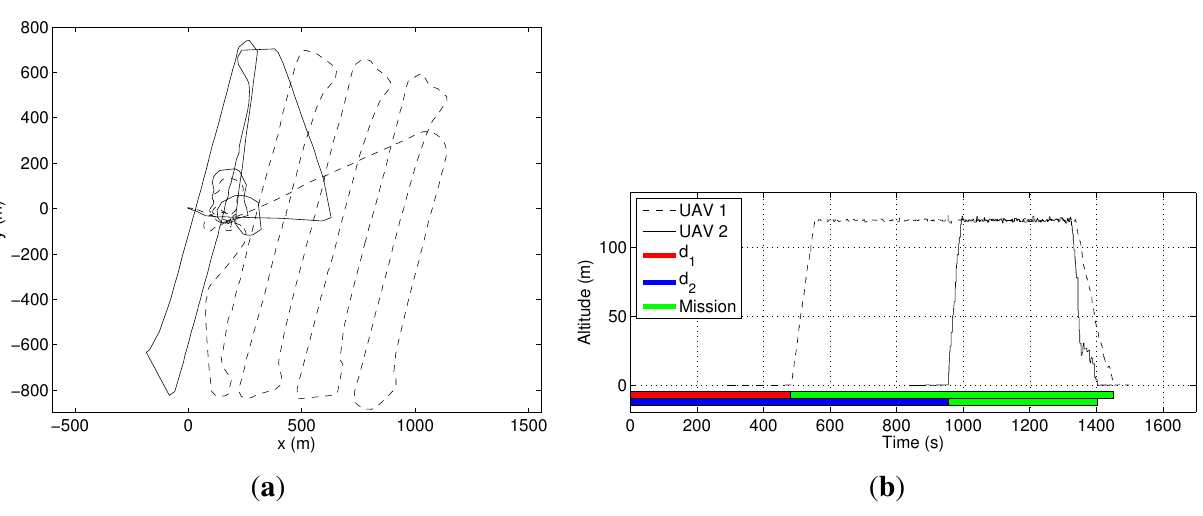
and d are the 1 2